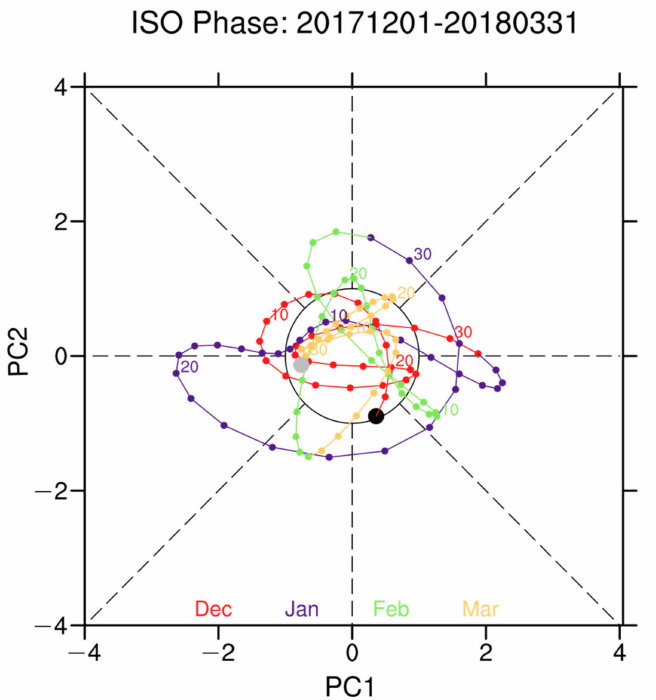
Figure 7. Evolution of the mid-high-latitude ISO and its amplitude from 1 December 2017 (the large black dot) to 31 March 2018 (the large gray dot). The red, purple, green, and yellow segments denote days in December 2017, January 2018, February 2018, and March 2018 respectively. The dates are marked every 10 days for each